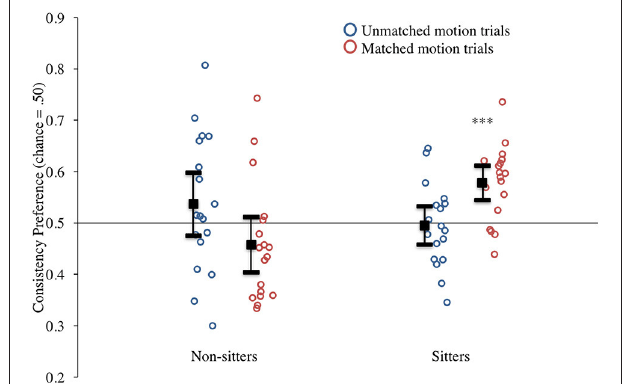
FIGURE 3 | Experiment 1 consistency preference scores for non-matched and matched motion trials by sitting status. Circles represent individual infants, solid black square represents mean responding. (Note: *** denotes p < 0.001, error bars represent 95% confidence